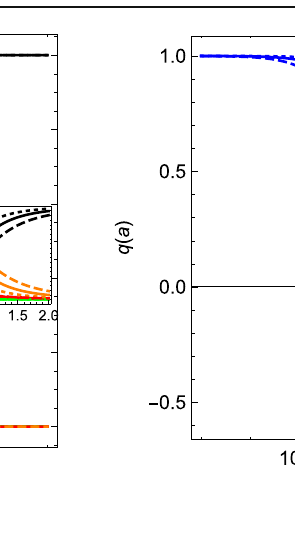
Fig. 4 The calculated deceleration parameter q as a function of a / a 0 . The present day a / a 0 = 1 is indicated by a vertical black solid line. The calculations are carried out for different parameters in generalized Rastall gravity. The cosmic evolution evaluated by using the specific initial conditions which reproduces the measurements is presented by solid curves. Those obtained by using different perturbed initial condi- tions are indicated by dashed and dotted curves